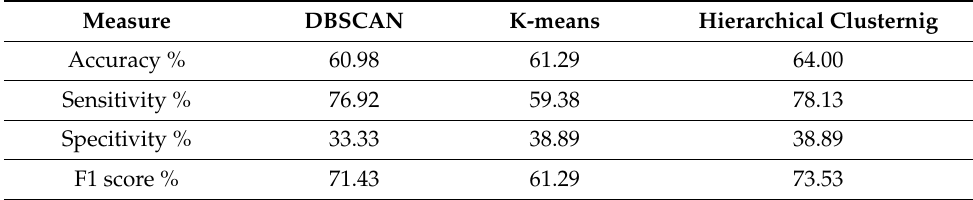
Table 3. DBSCAN, K-means and Hierarchical Clustering